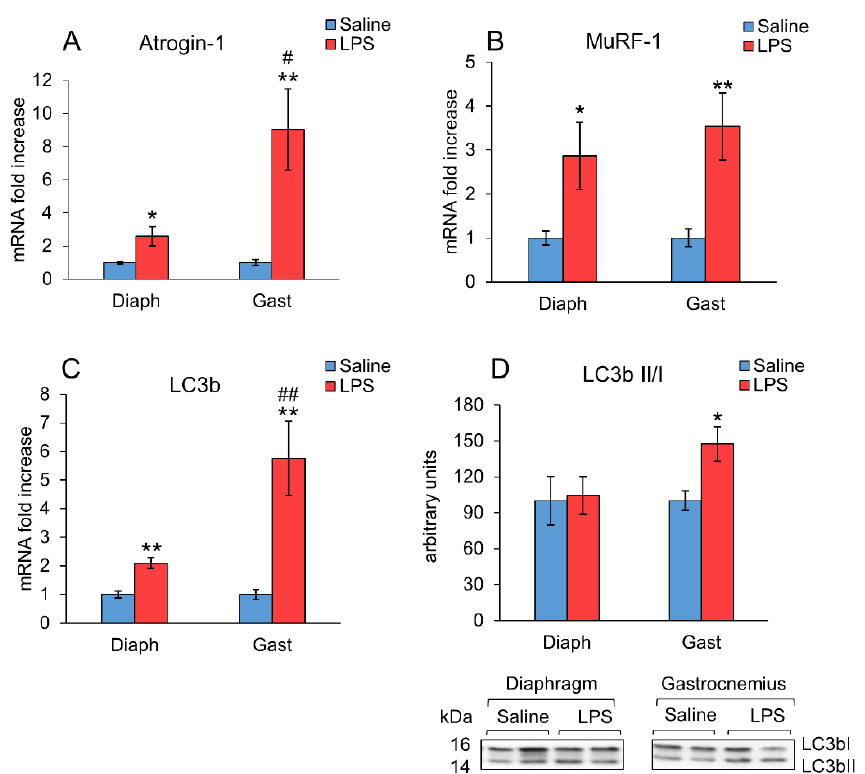
Figure 1. Effect of sepsis induced by lipopolysaccharide (LPS) injection (10 mg/kg ip.) on ( A ) Atrogin- 1 mRNA, ( B ) MuRF1 mRNA, ( C ) LC3b mRNA, and ( D ) LC3b-I, and its lipidated form LC3b-II, in rat diaphragm and gastrocnemius muscles, 24 h after a single injection of LPS or saline solution. mRNA was measured by PCR and proteins by Western blot. Representative Western blots are shown in D (bottom). Data represent mean ± standard error of the mean (SEM) for n = 7–8 rats/group. * p < 0.05 and ** p < 0.01 versus their respective control rats treated with saline, # p < 0.05 and ## p < 0.01 versus the diaphragm of rats treated with LPS. Diaph: diaphragm, Gast: gastrocnem- ius.